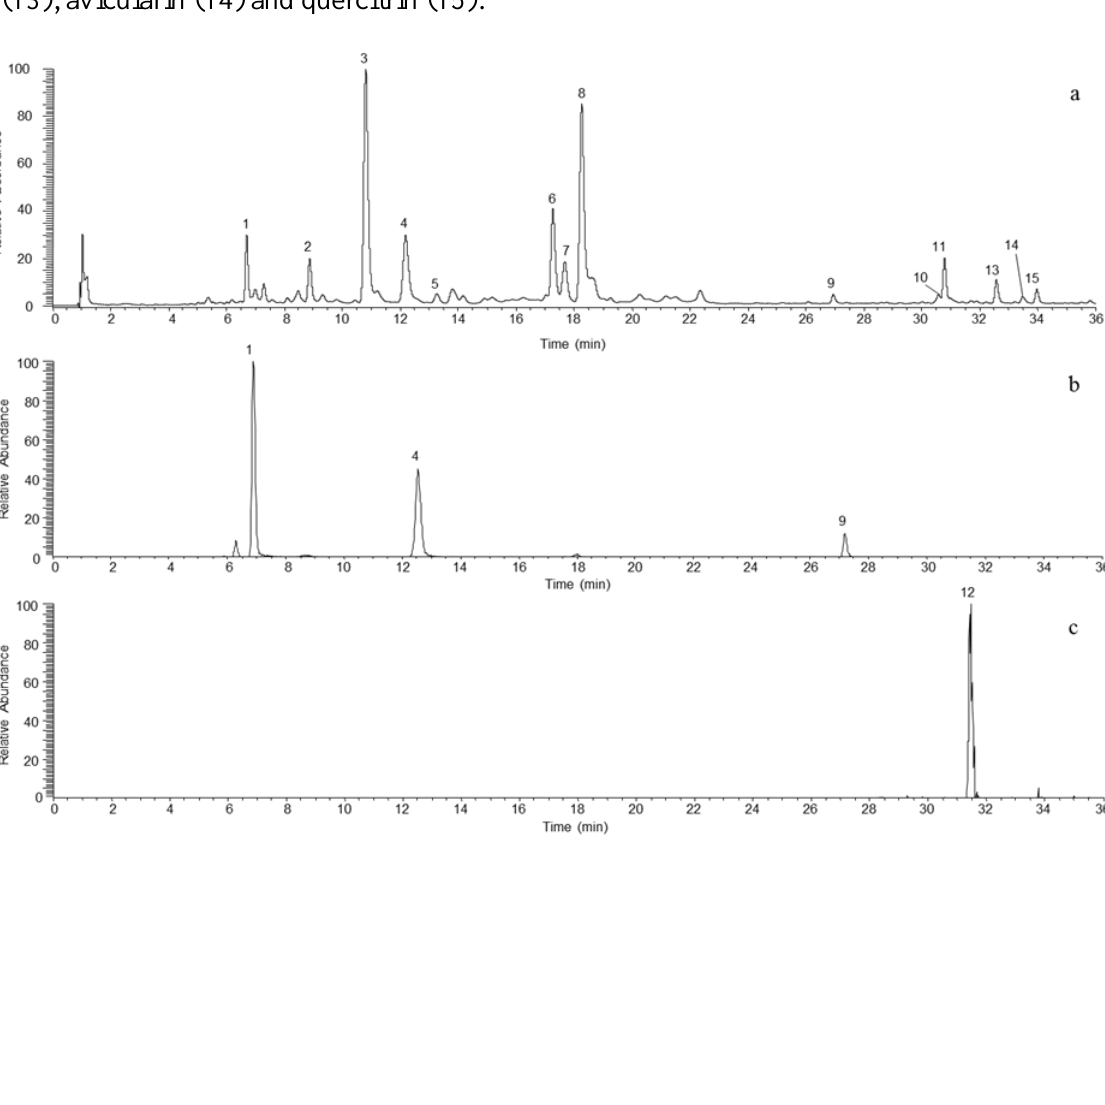
Figure 2. UHPLC chromatograms: ( a ) UV (λ 280 nm); ( b ) SRM for procyanidin; ( c ) SRM for rutin. Procyanidin B1 (1), catechin (2), chlorogenic acid (3), procyanidin B2 (4), 4-caffeoylquinic acid (5), epicatechin (6), procyanidin C1 (7), 4- p -coumaroylquinic acid (8), procyanidin B5 (9), hyperin (10), phloretin xyloglucoside (11), rutin (12), phloridzin (13), avicularin (14) and quercitrin